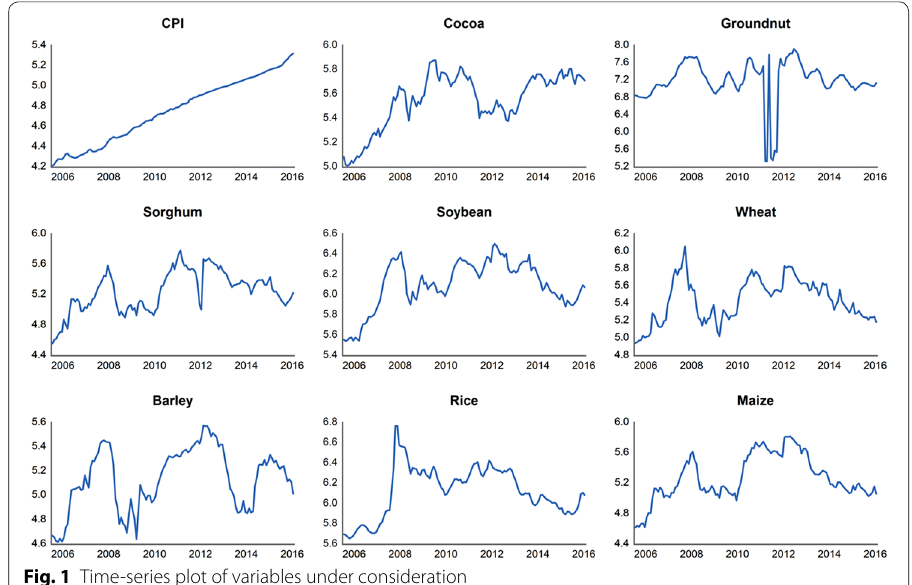
Fig. 1 Time-series plot of variables under